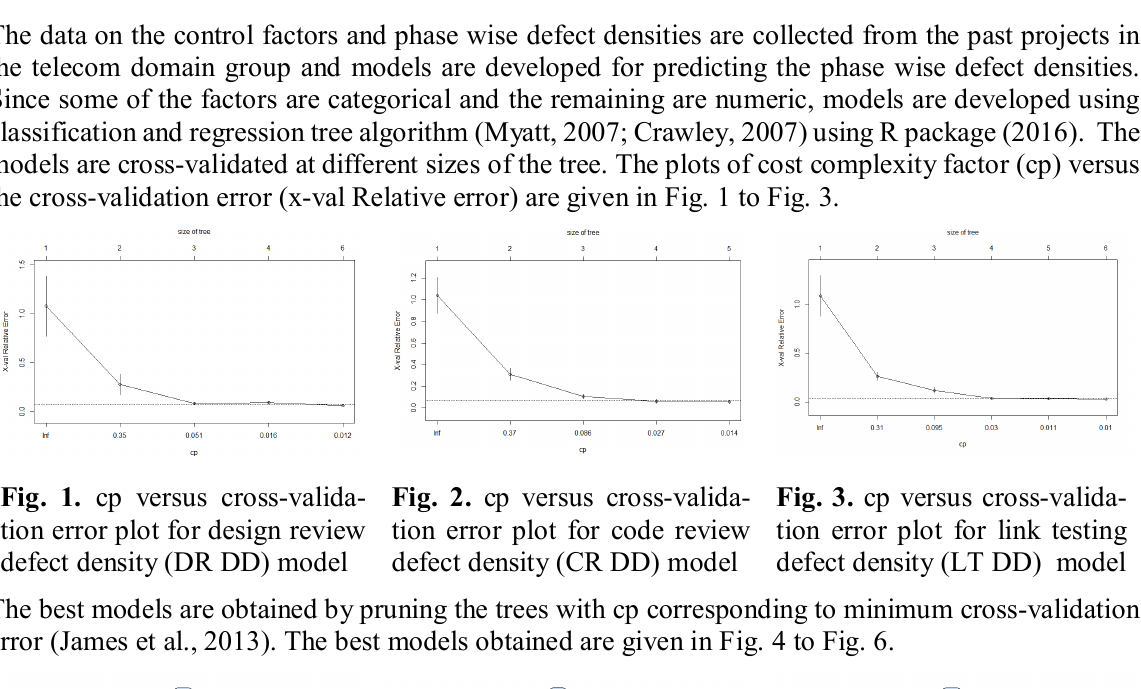
Fig. 3. cp versus cross-valida- tion error plot for link testing defect density (LT DD) model